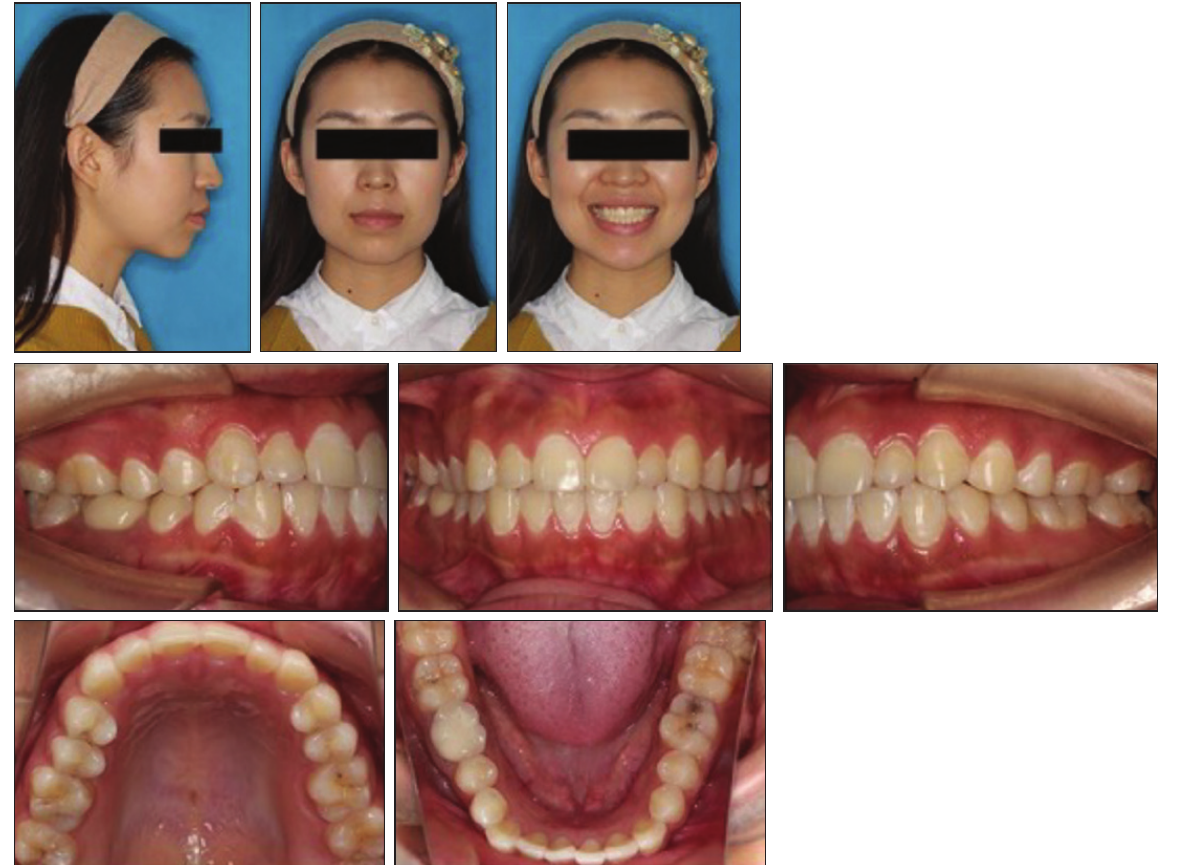
Figure 1. Pretreatment facial and intraoral